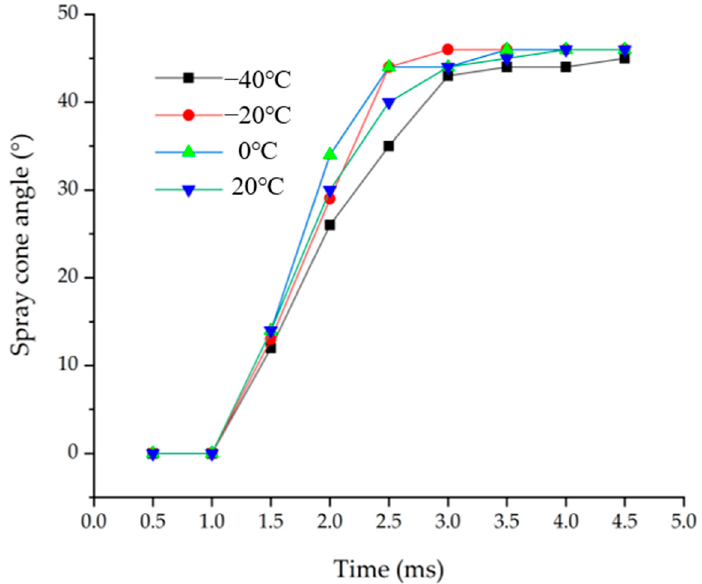
Figure 10. Comparison of the spray cone angle at different temperatures over time.